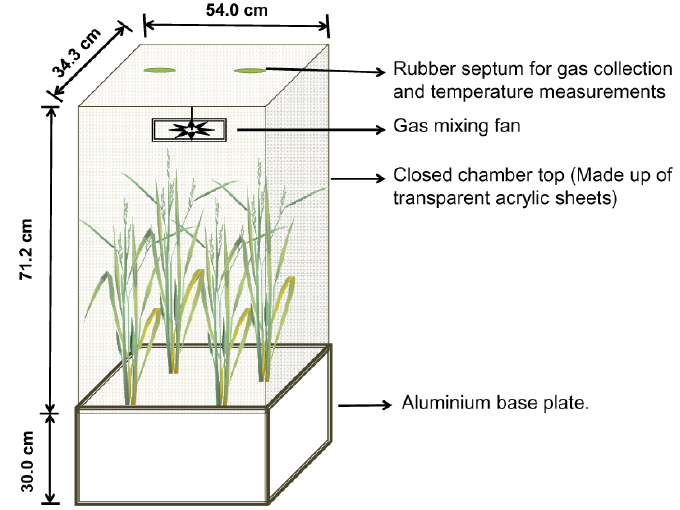
Figure 2. Diagram of closed diffusion chambers system used to collect methane emission in the rice